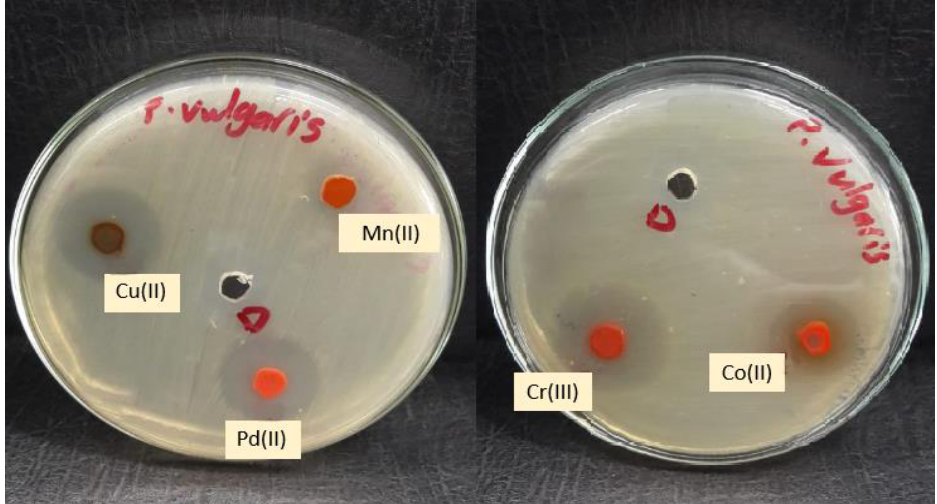
Figure 16. Microbiological screening of coordination compounds of Mn(II), Co(II), Cu(II), Cr(III), and Pd(II) toward Proteus vulgaris.